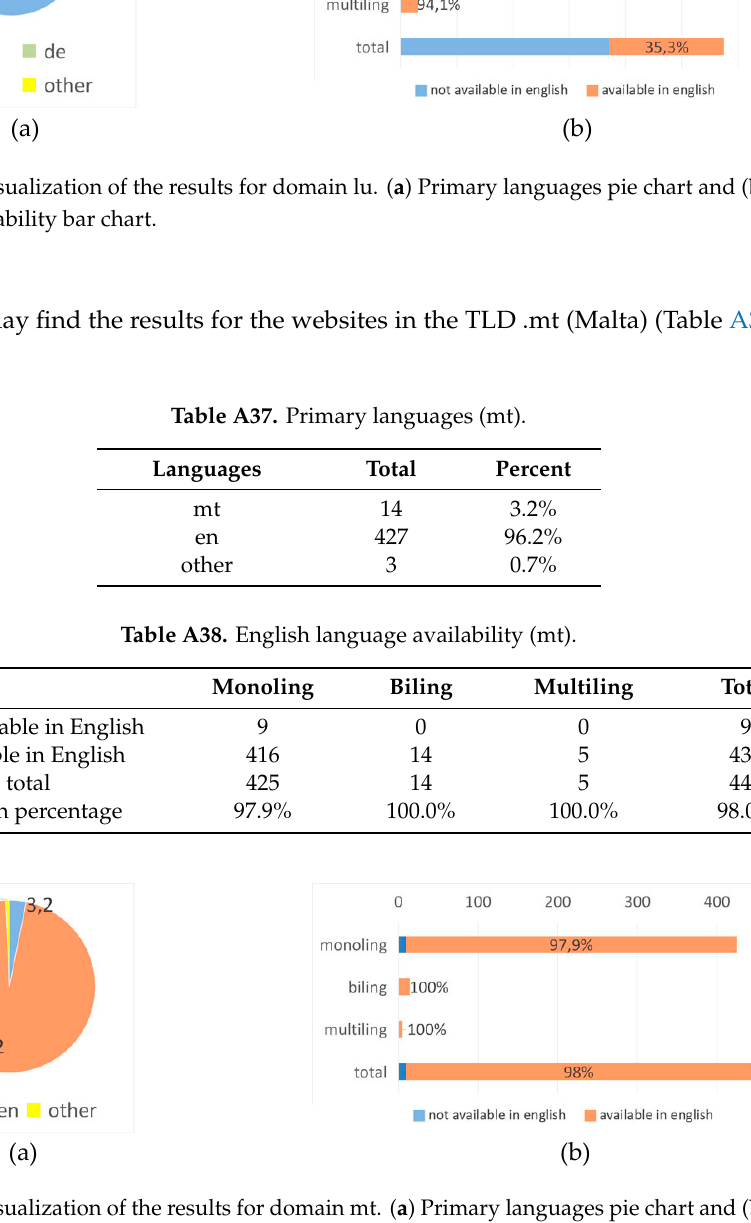
Table A39. Primary languages (nl).